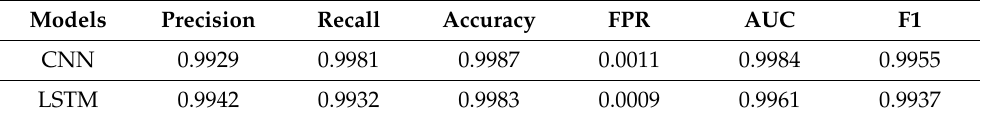
Table 4. Results obtained with LSTM and CNN models by applying 10-fold cross-validation.